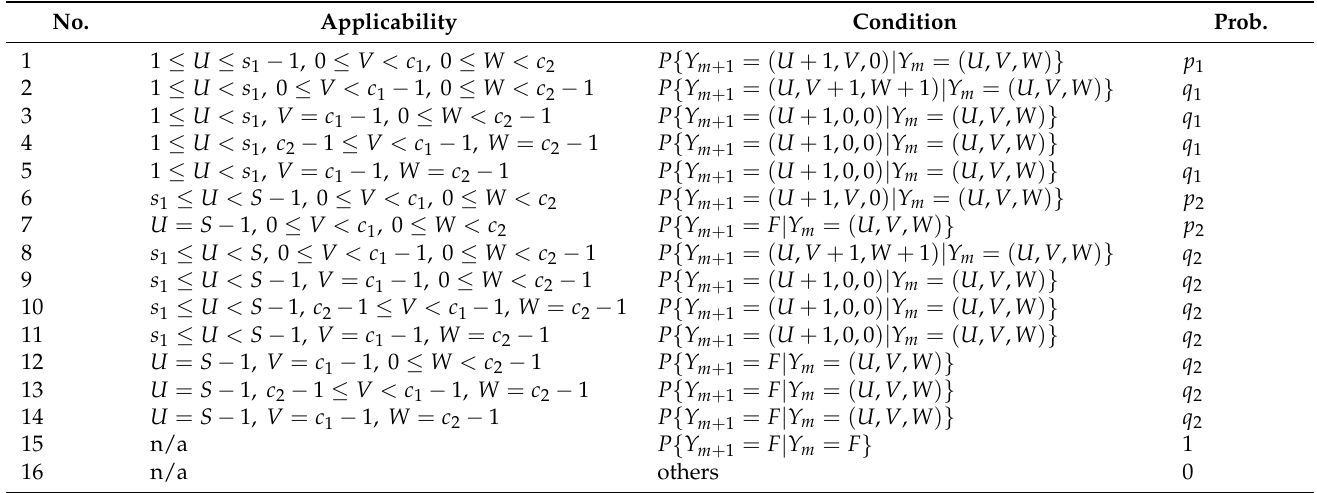
Table 1. Transition rules in Λ